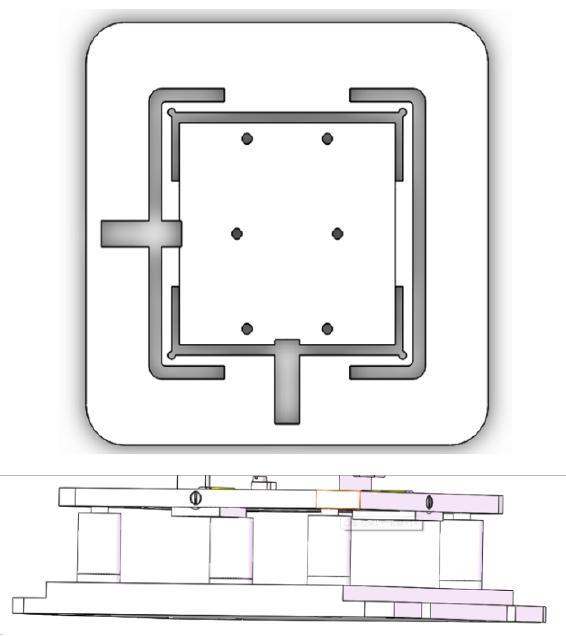
Fig. 1. Designed three DOFs platform.